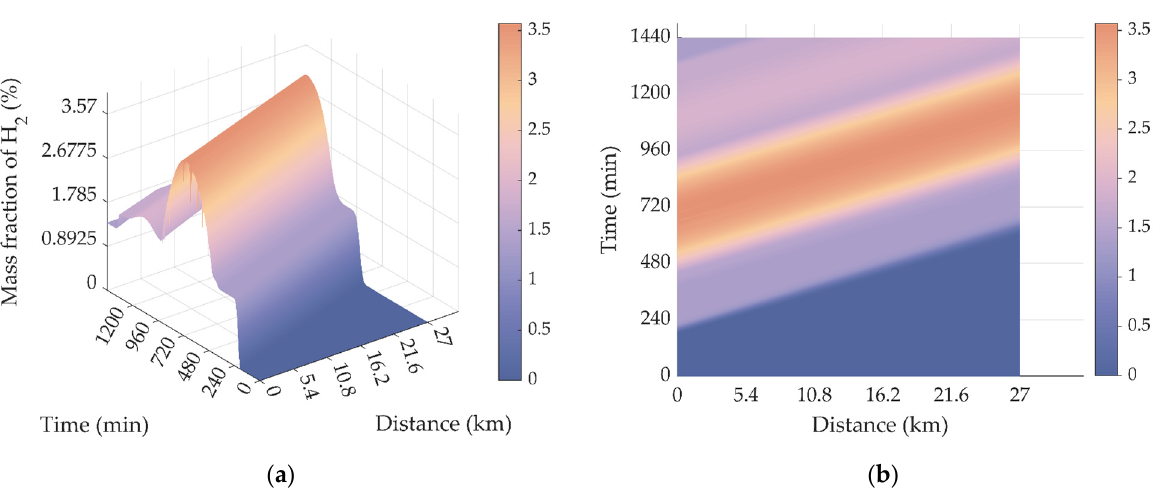
Figure 12. The distribution of hydrogen mass fraction in Pipe 5 in Scenario I: ( a ) Three-dimensional diagram; ( b ) top view.